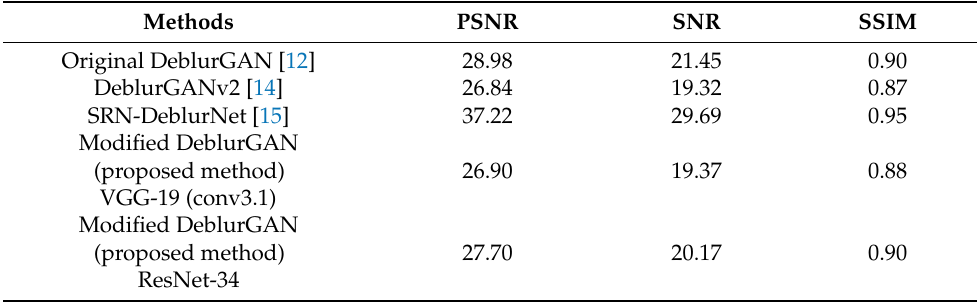
Table 9. Comparisons of blur restoration by using the state-of-the-art methods and proposed modified DeblurGAN with PolyU-DB.